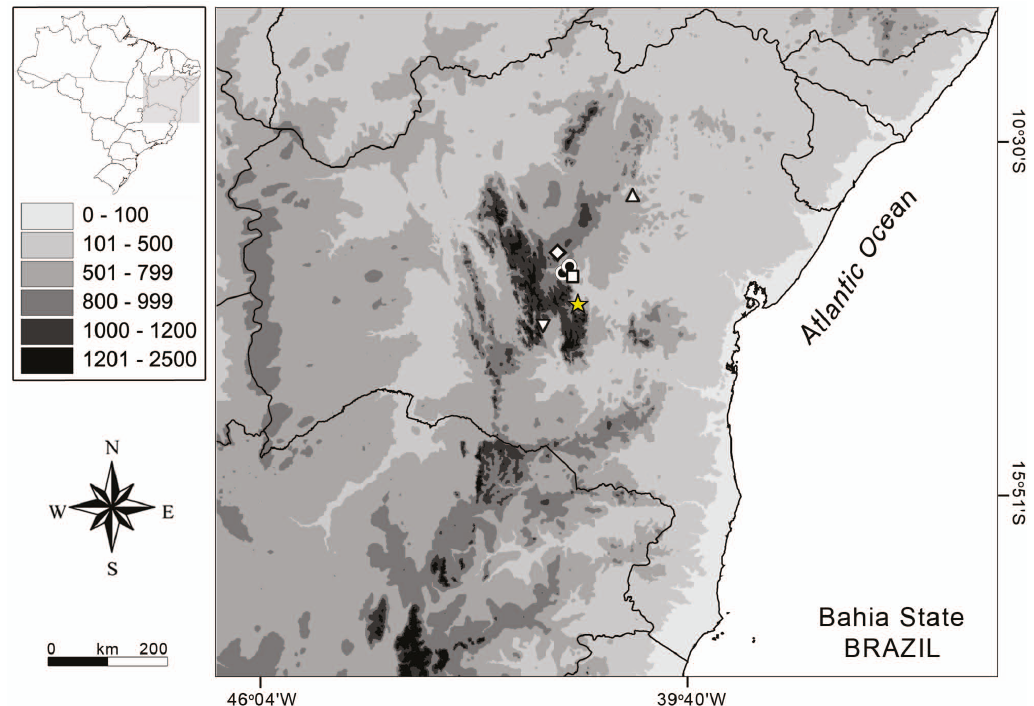
Figure 2. Geographic distribution